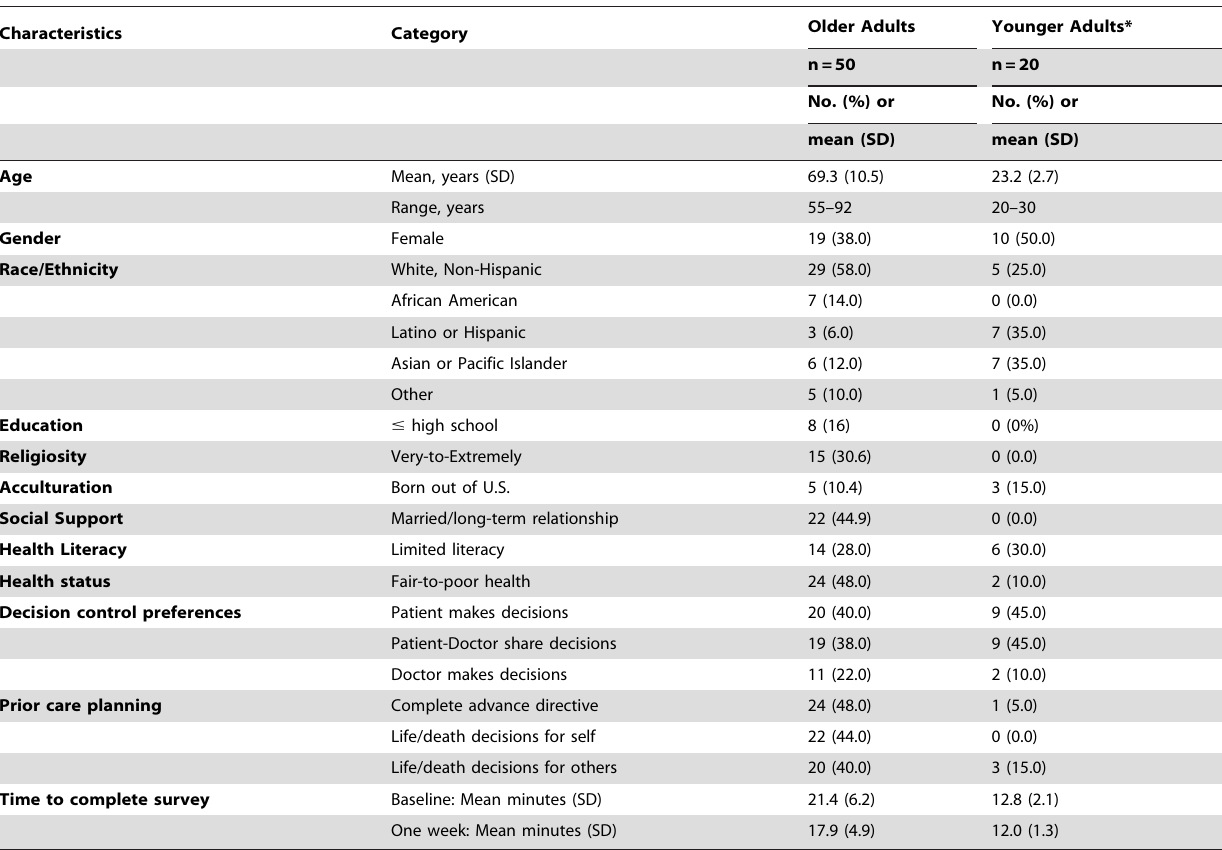
Table 3. Participant Characteristics.